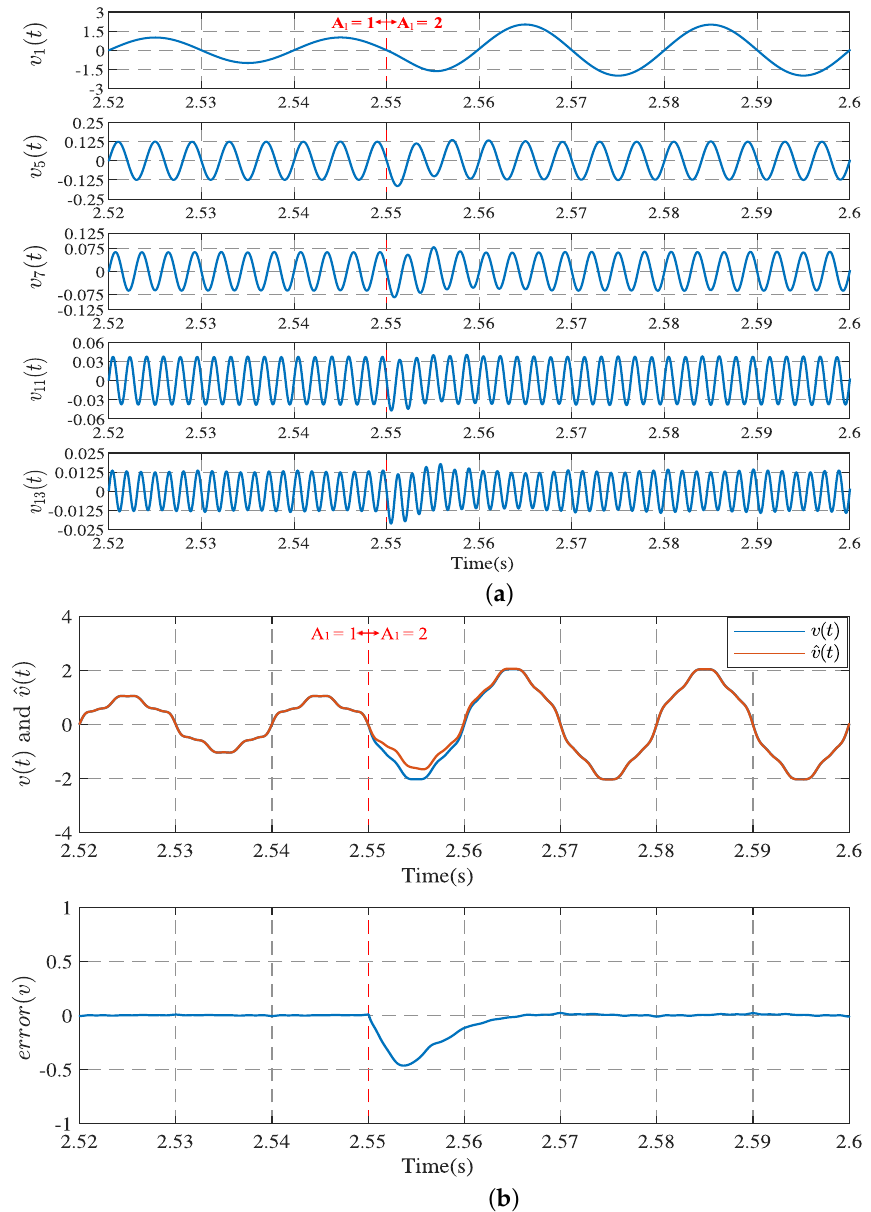
Figure 6. Real-time simulation results: ( a ) The effect of extracting each harmonic after the jump in the fundamental amplitude of the input signal; ( b ) Comparison of the observer results with the real signal and the error